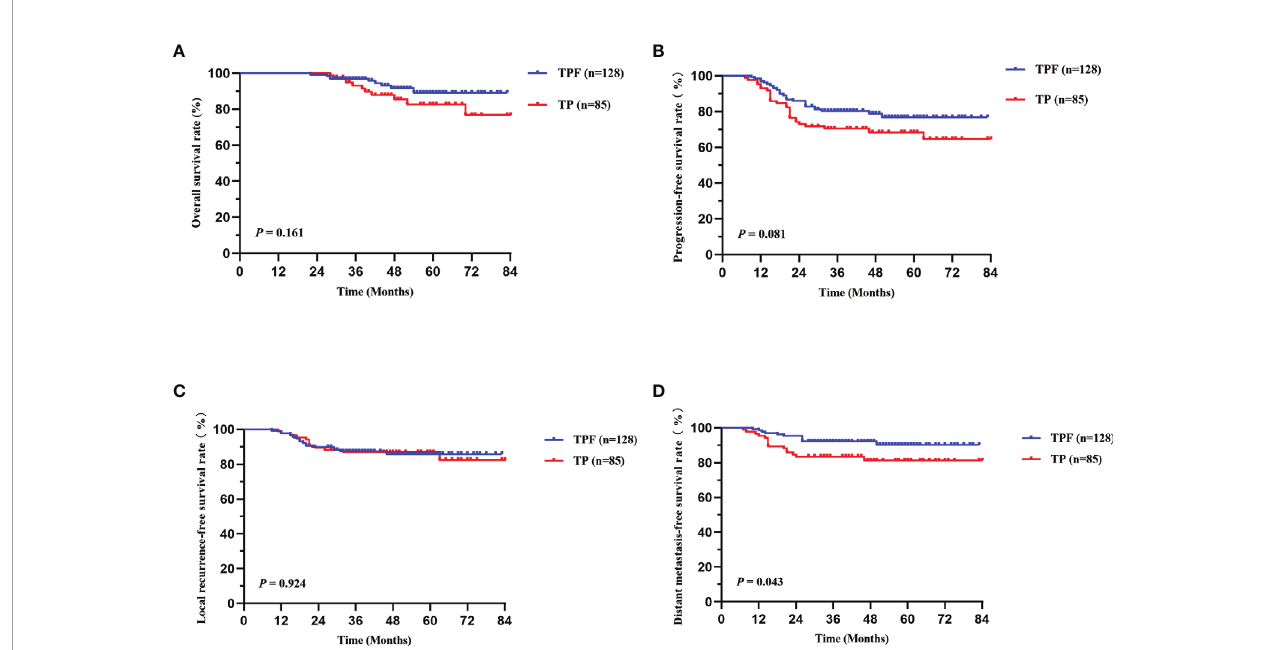
FIGURE 2 | Kaplan-Meier survival curves of OS (A) , PFS (B) , LRFS (C) , and DMFS (D) between TPF and TP groups in locally advanced patients. TPF, docetaxel, cisplatin, and 5- fl uorouracil; TP, docetaxel and cisplatin; OS, overall survival; PFS, progression-free survival; LRFS, locoregional relapse-free survival; DMFS, distant metastasis-free